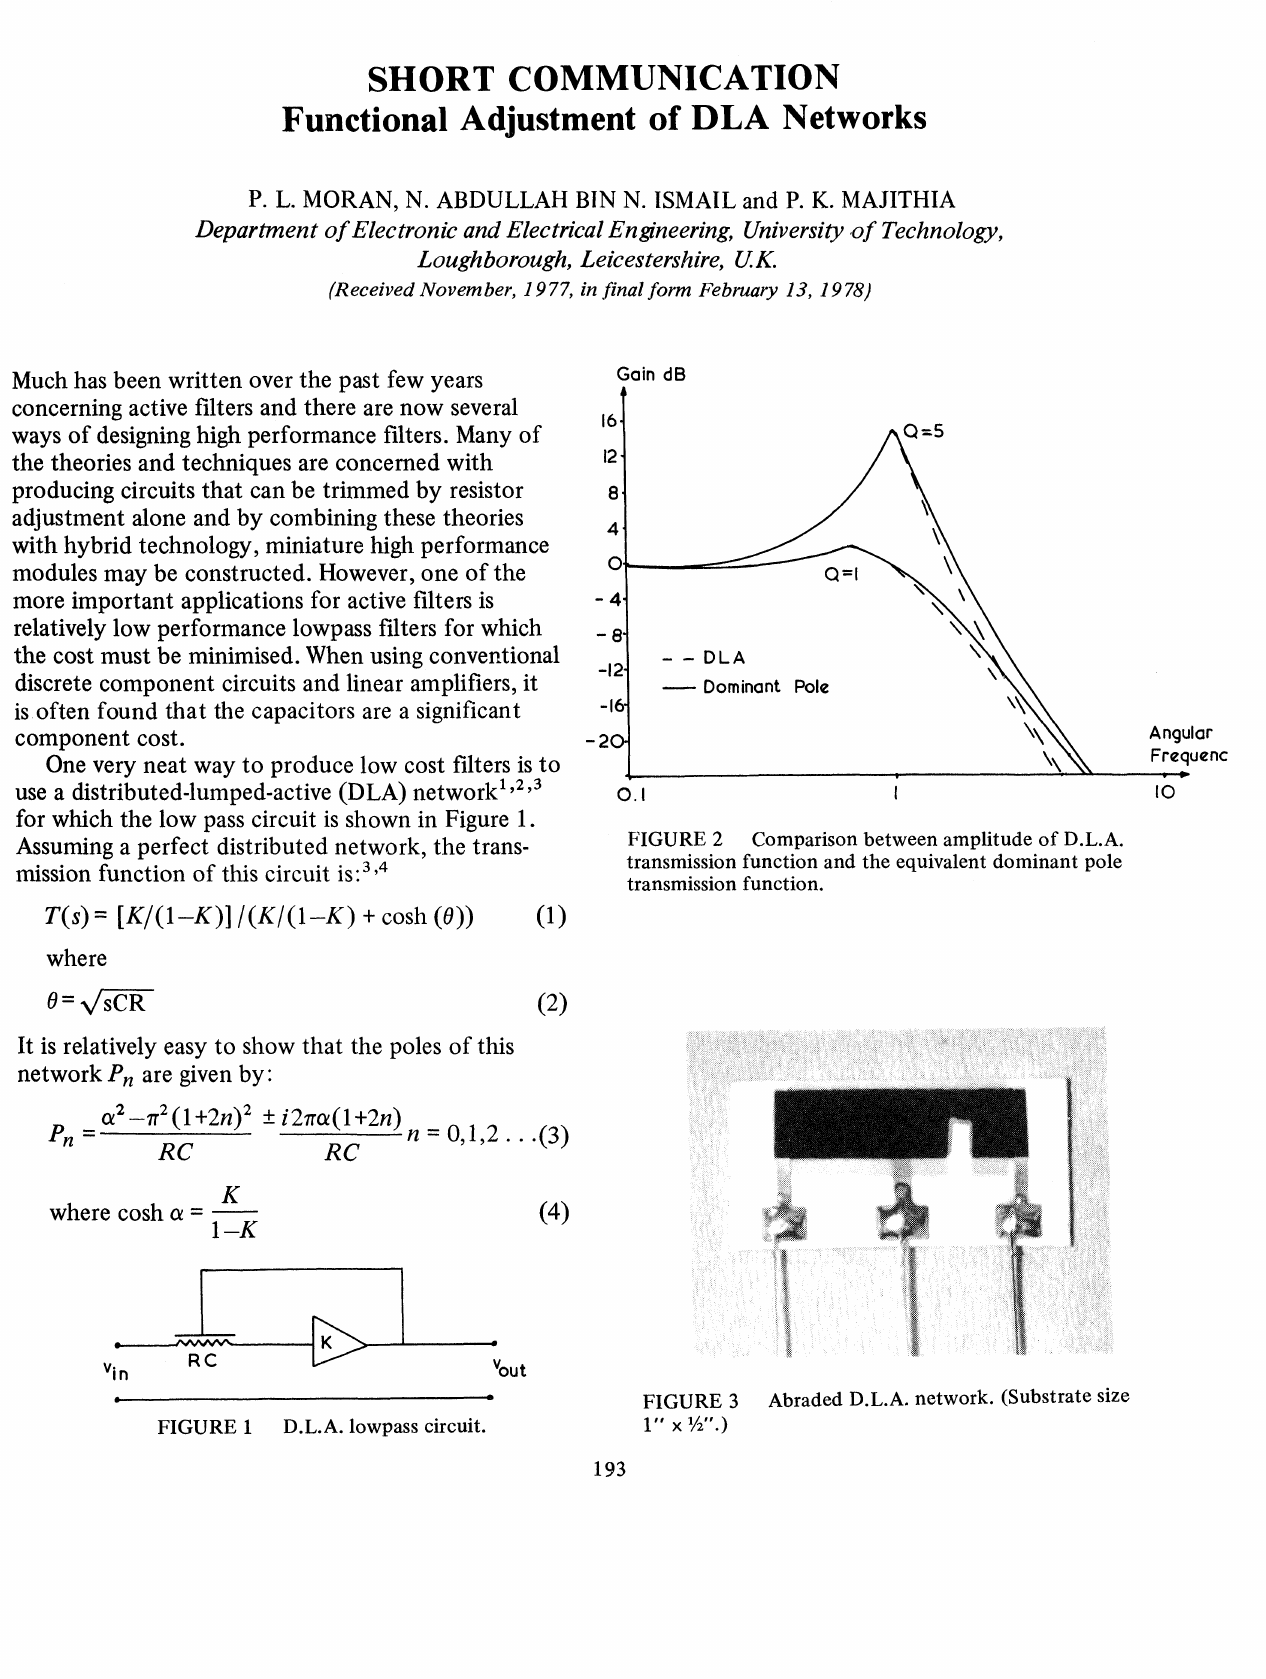
D.L.A. lowpass circuit.